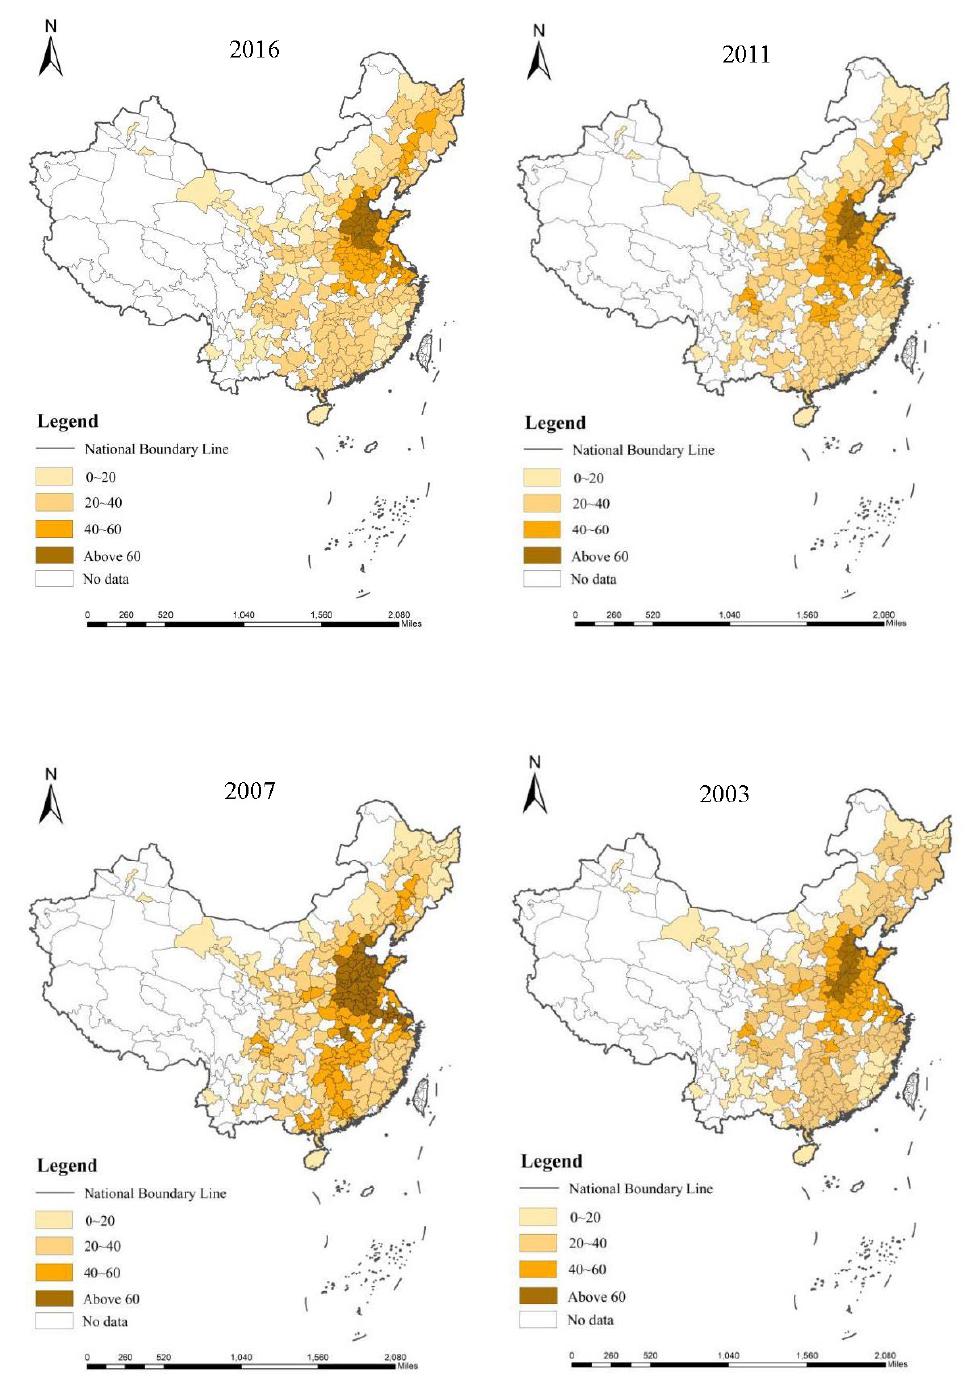
Figure 2. Annual average concentration of PM 2.5 in Chinese cities from 2003 to